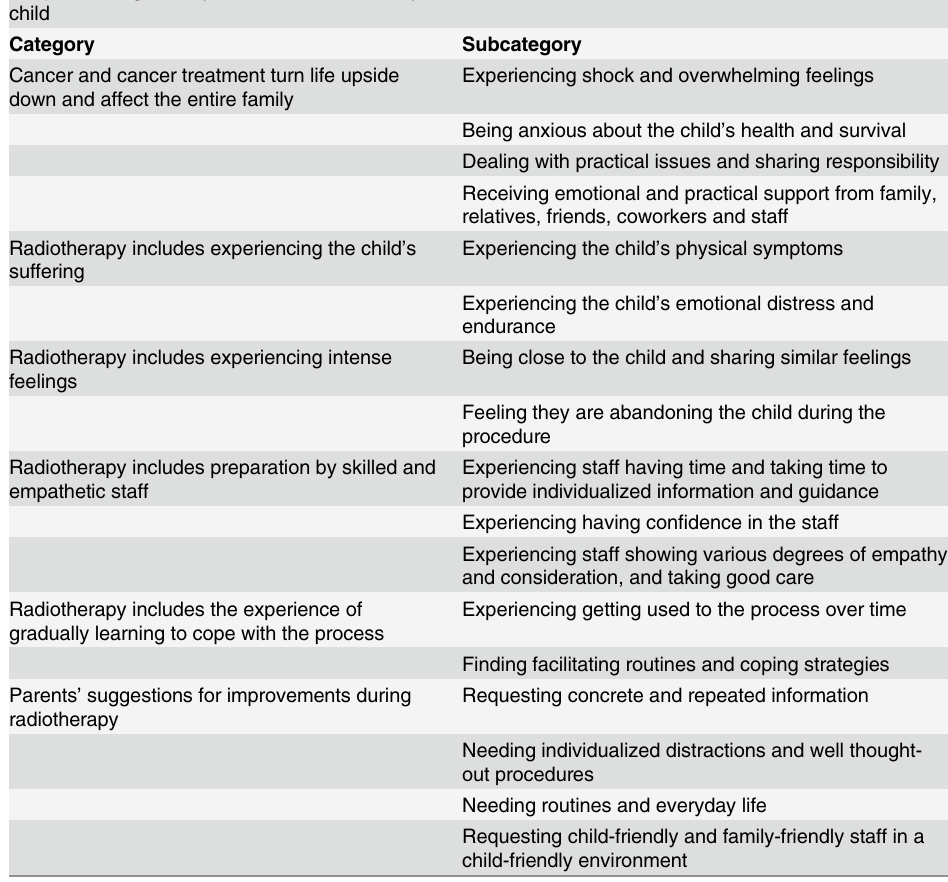
Table 1. Theme, category, and